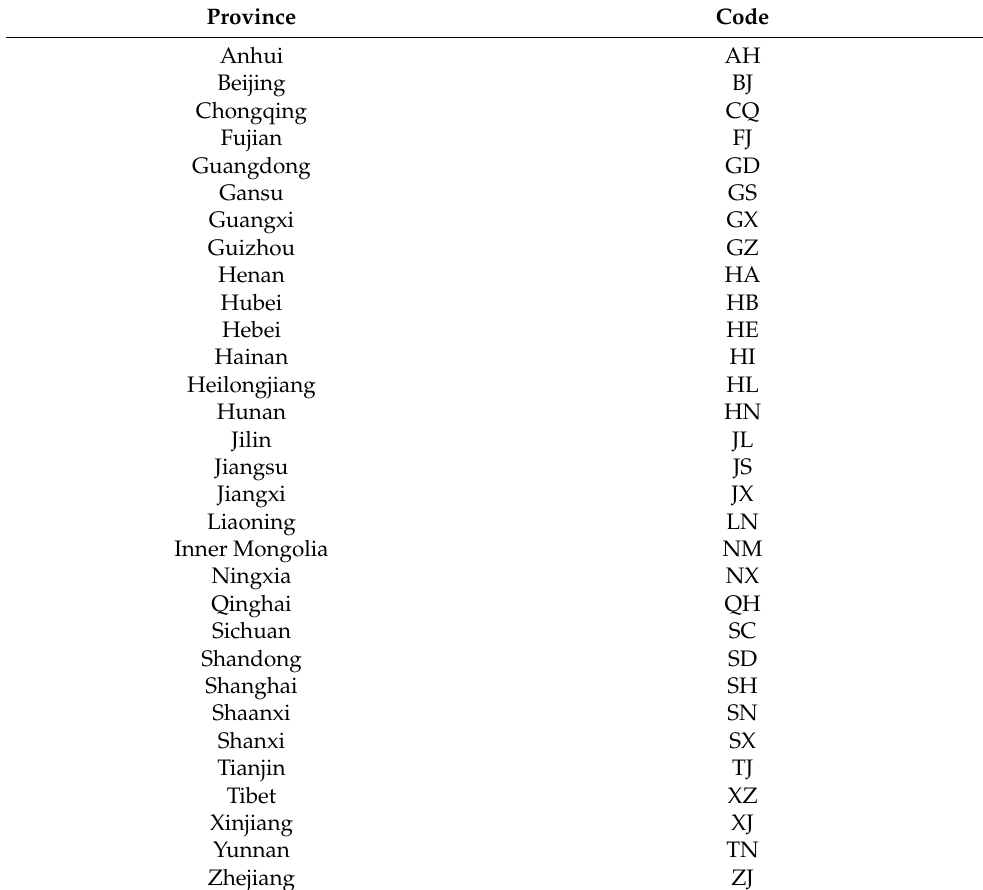
Table A1. Province codes used in the main